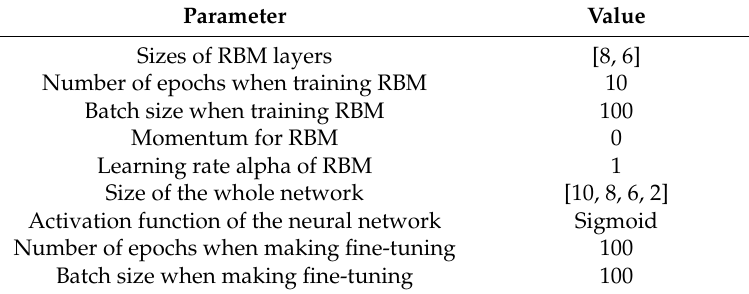
Table 5. Parameter settings of the deep belief network